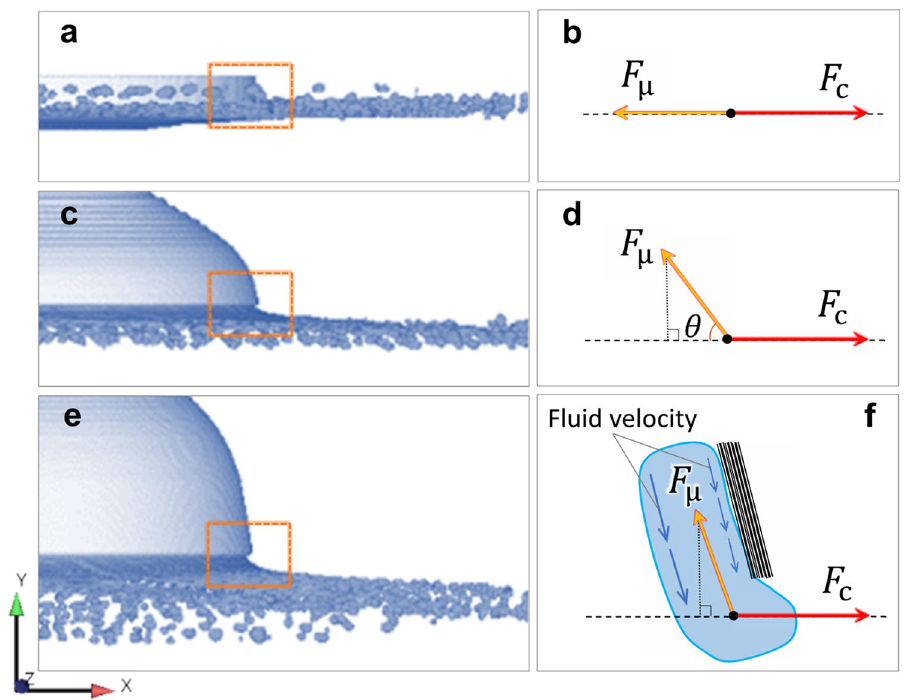
Figure 12. Top views of the simulation cases with the end surface morphology of ( a , b ) flat plane, ( c , d ) shallow depression, and ( e , f ) deep depression. Schematics show that as the depression depth increased, the angle θ increased; thus, the resultant force of the centrifugal force F c and the viscous resistance F µ along the radial F µ cos θ ) was direction ( F c − ·